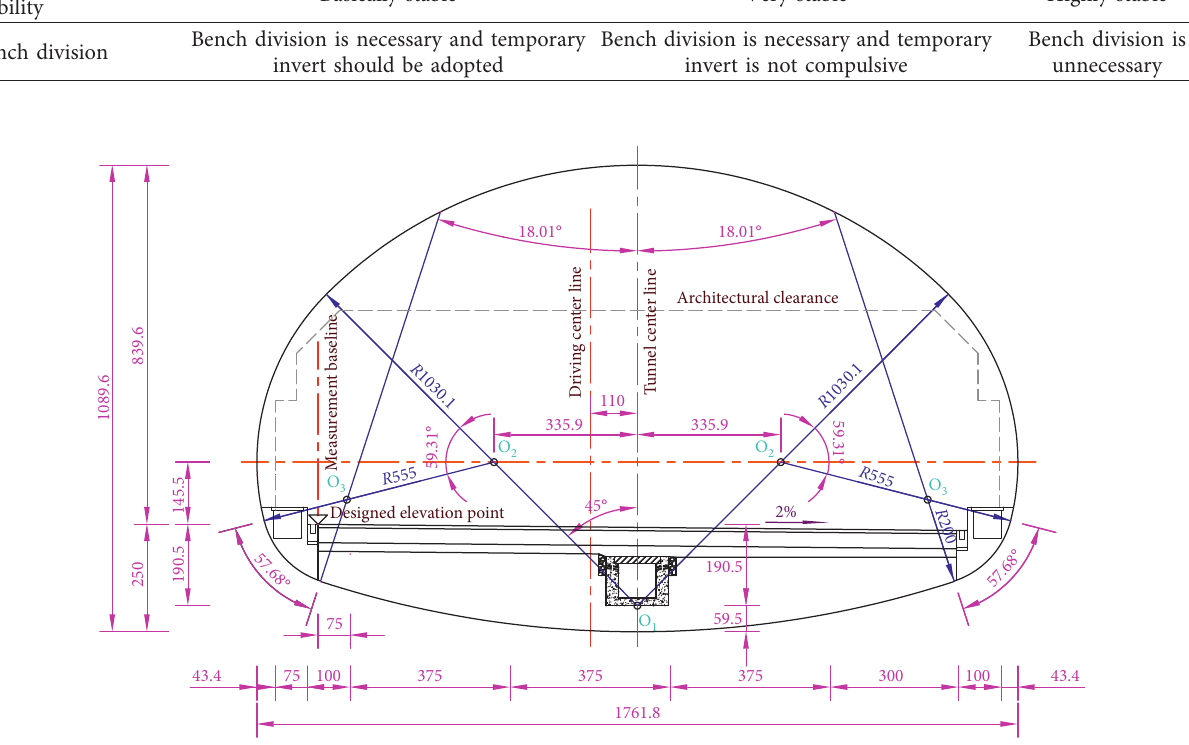
Figure 8: Inside outline of Malin tunnel. Table 12: Calculation results of Malin tunnel construction method.